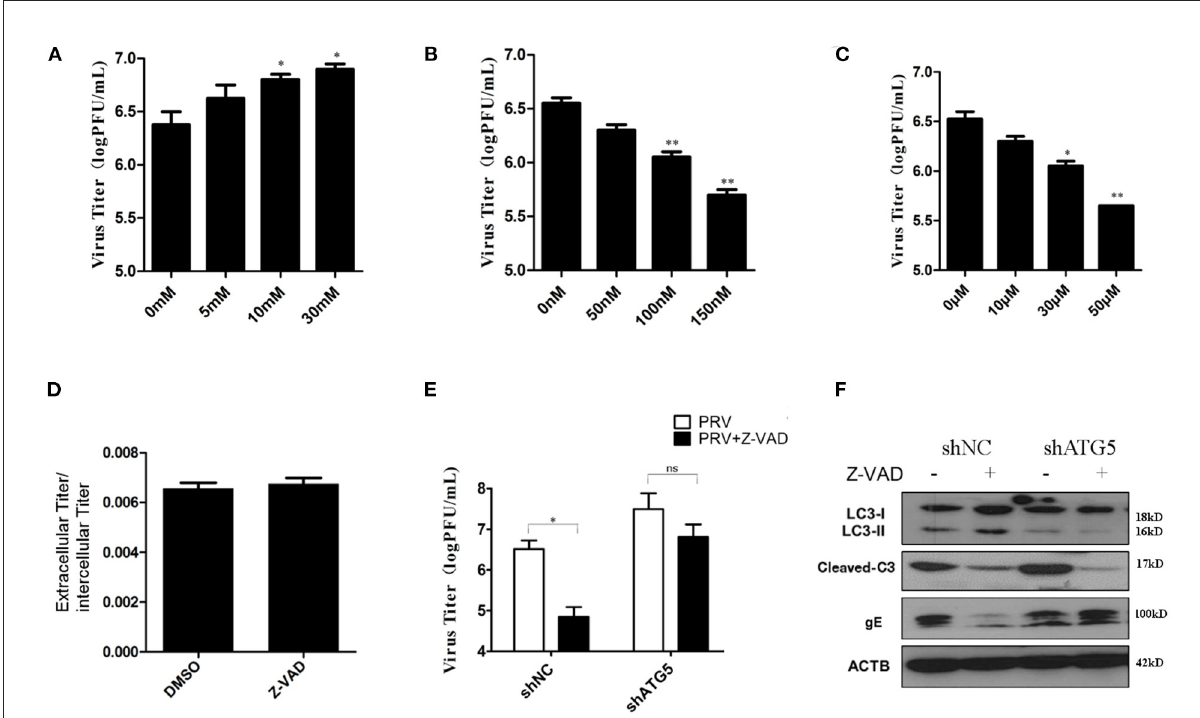
FIGURE5 Autophagy had a more important effect in PRV replication. (A) PK-15 cells were treated with 3-MA followed by PRV infection (MOI = 1). The viral titer was determined by PFU assay. (B) PK-15 cells were treated with rapamycin, followed by PRV infection (MOI = 1). The viral titer was determined by PFU assay. (C) PK-15 cells were treated with Z-VAD-FMK followed by PRV infection (MOI = 1). The viral titer was determined by PFU assay. (D) The ratio of the virus titers in the supernatants and cell lysates was determined according to the results of the PFU assay. (E) The combined effect of autophagy and apoptosis on PRV infection. PK-15 cells were transfected with shATG5 for 24h and then treated with Z-VAD-FMK for an additional 4h followed by PRV infection. The viral titer was determined by PFU assay, and the autophagy level and apoptosis level were tested by Western blot shown in (F) . The data represent the mean ± SD of three independent experiments and are analyzed by two-way ANOVA, * P < 0.05; ** P < 0.01.